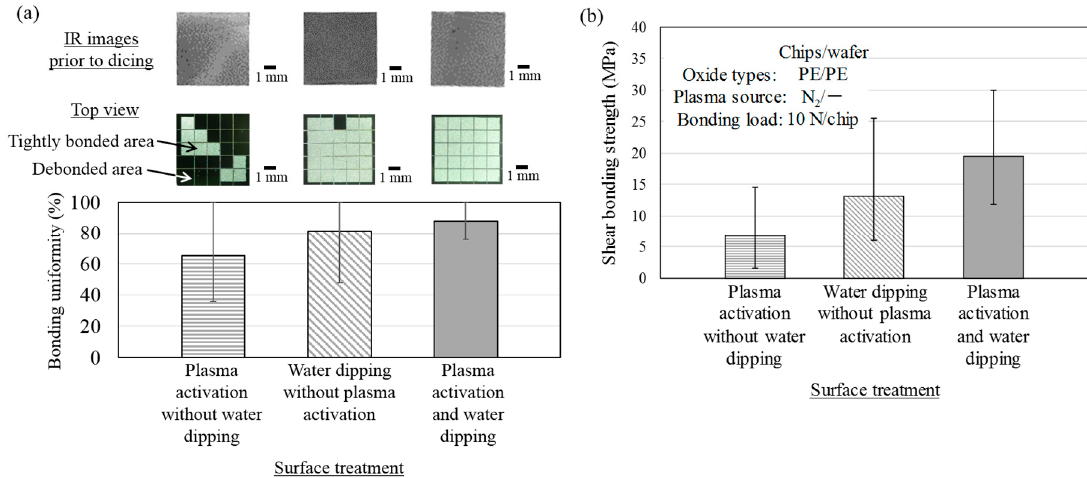
Figure 5. Bonding uniformity of chips directly bonded to wafers conditioned with different surface treatments ( a ). The IR images of chips are taken after MCtW direct bonding prior to dicing and the top views show a whole chip after dicing. The error bars indicate the max. and min. ratio of “the number of non-debonded 1-mm-square small dielets per a 5-mm-square chip” to “25 (the total number of the small dielets after dicing per the chip)”. Shear bonding strengths of chips directly bonded to wafers conditioned with different surface treatments ( b ).